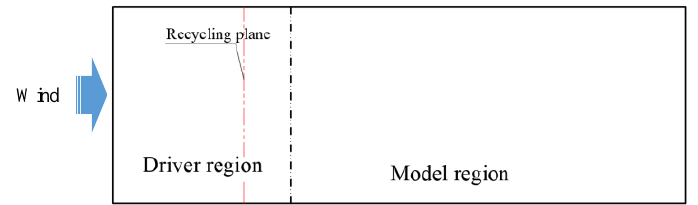
Figure 3. Solution domain setup.